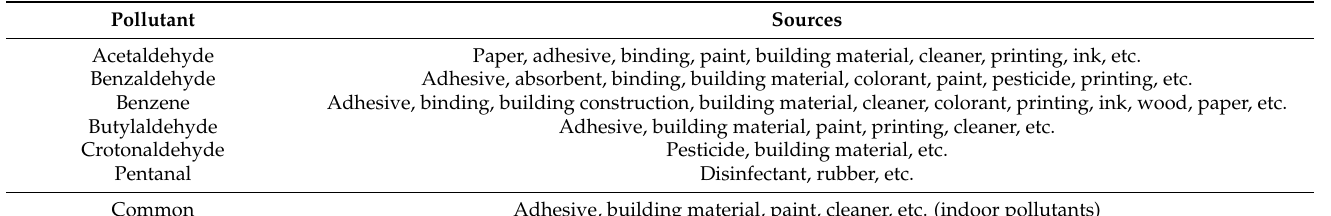
Table 9. Sources of pollutants in the second principal component